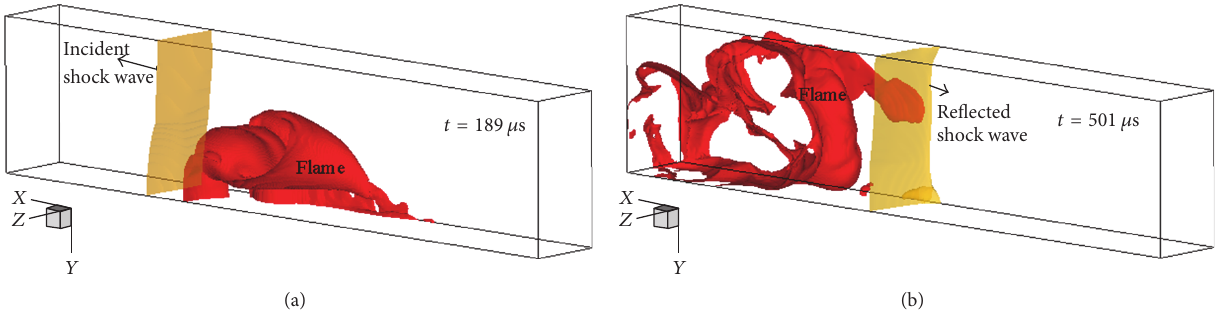
Figure 4: Different flame structures at selected typical times (isosurface with red color corresponds to flame surface; yellow color represents pressure).